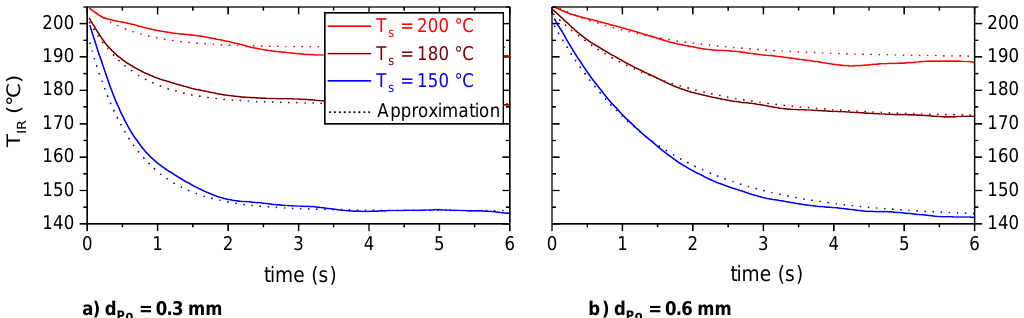
Figure 14. Analytical approximation according to Equation (5) of the experimental temperature profiles, T IR (t), for d Po = 0.3 mm ( a ) and d Po = 0.6 mm ( b ) high traces. For the analytical calculation, the average values of T IR,e and T IR,plat (cf. Table 2) were used.